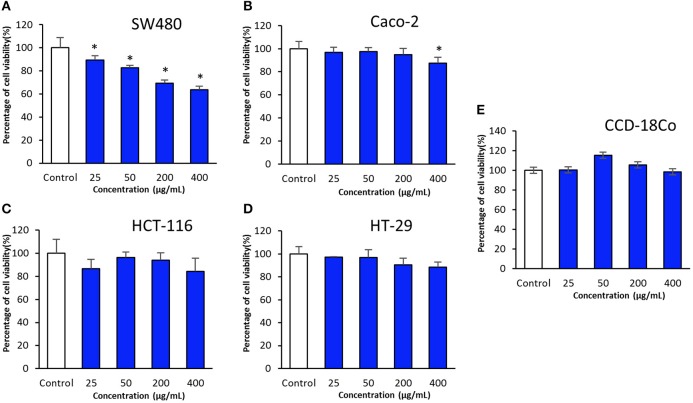
Cytotoxic activity of MUSC 93JT extract against human colon cancer and normal cell lines. The measurement of cell viability was done using MTT assay. The graphs show cytotoxicity effect of MUSC 93JT extract against (A) SW480, (B) Caco-2, (C) HCT-116, (D) HT-29, and (E) CCD-18Co. All data are expressed as mean ± standard deviation and significance level are set as 0.05. Symbol (*) indicates p < 0.05 significant difference between the cells treated with MUSC 93JT extract and control (without MUSC 93JT extract).